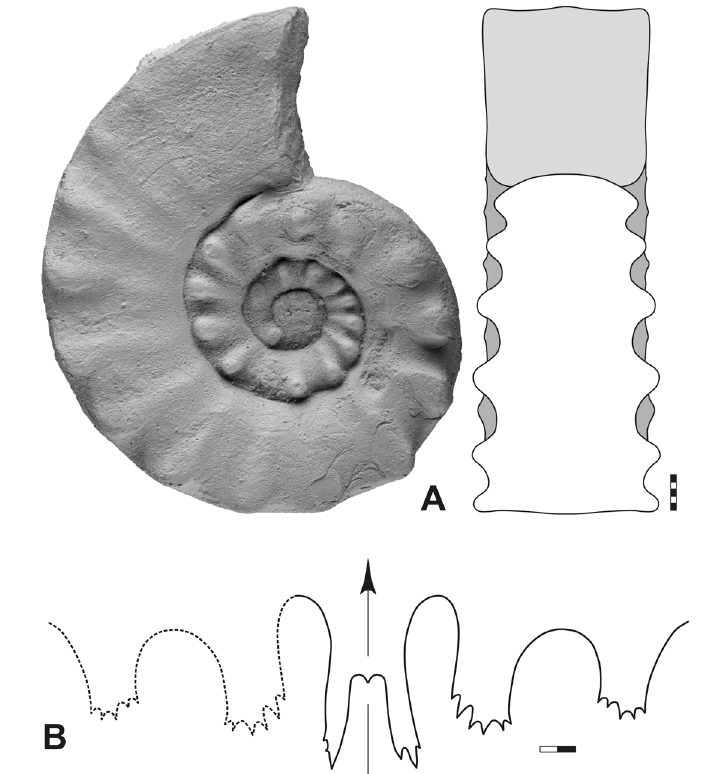
Fig. 38. Paratirolites quadratus Korn & Ghaderi, 2016. A . Lateral and dorsal view, specimen MB.C.29932, section E, float. B . Suture line, specimen MB.C.29932, at 13.5 mm wh. Abbreviation: see Material and methods. Scale bar units = 1 mm.